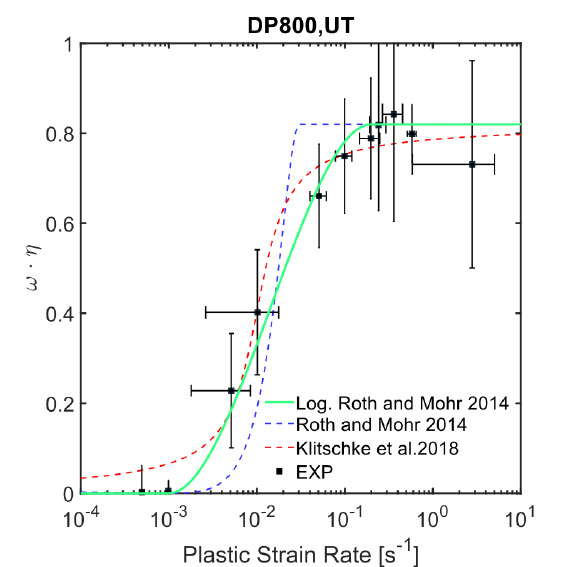
Fig. 4. Transition from isothermal to adiabatic conditions for a range of strain rates. Experimental results are shown as green squares with error bars. The proposed transition function is plotted as a solid green line while the previously proposed functions by [1] and [3] are shown in dashed curves.